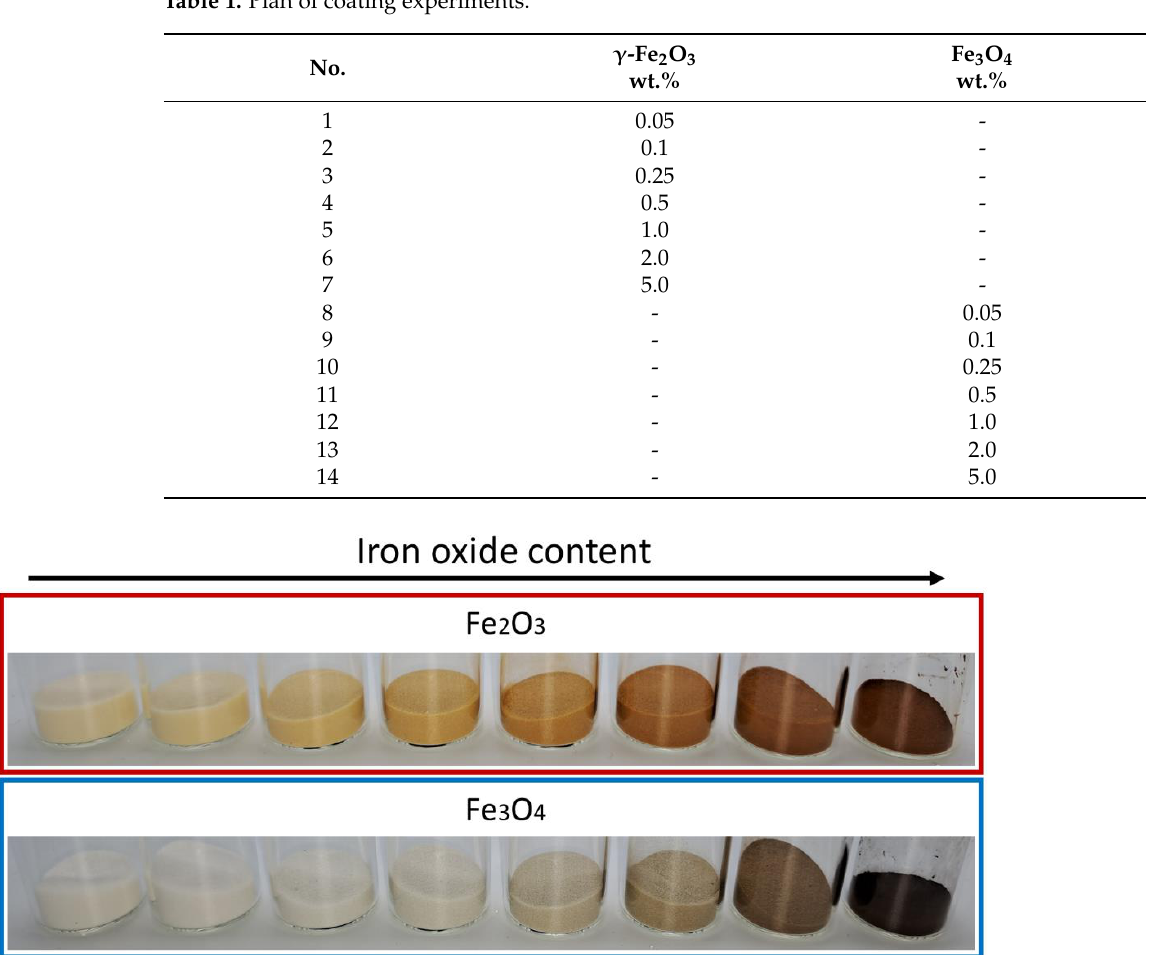
Figure 3. Change in color of the coated powders. From left to right, increase of iron oxide content from 0.05 to 5 wt.% according to experiments listed in Table 1. The last beaker in each row (most right position) shows the pure SPIONs.